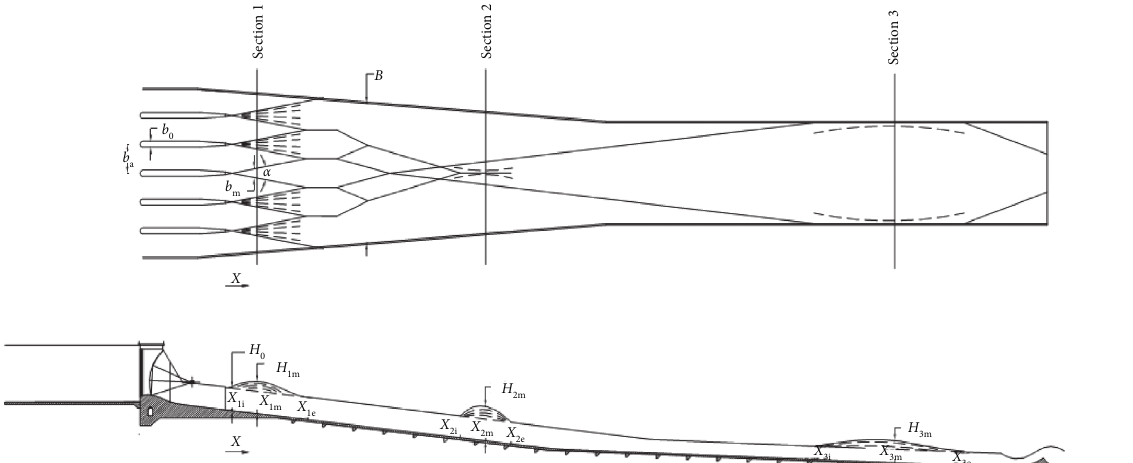
Figure 1: Waves at the downstream of pier chutes: (a) plan and (b) flow longitudinal section (the Kheirabad Dam is located in Khuzestan Province, Iran).